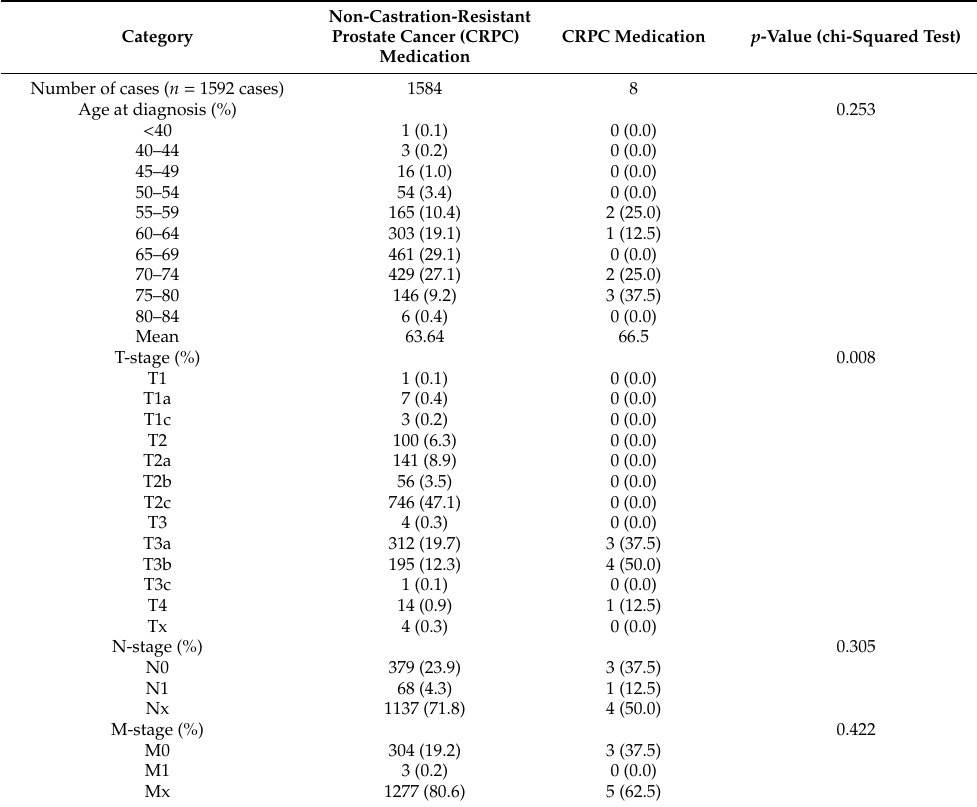
Table 1. Demographics of prostate cancer